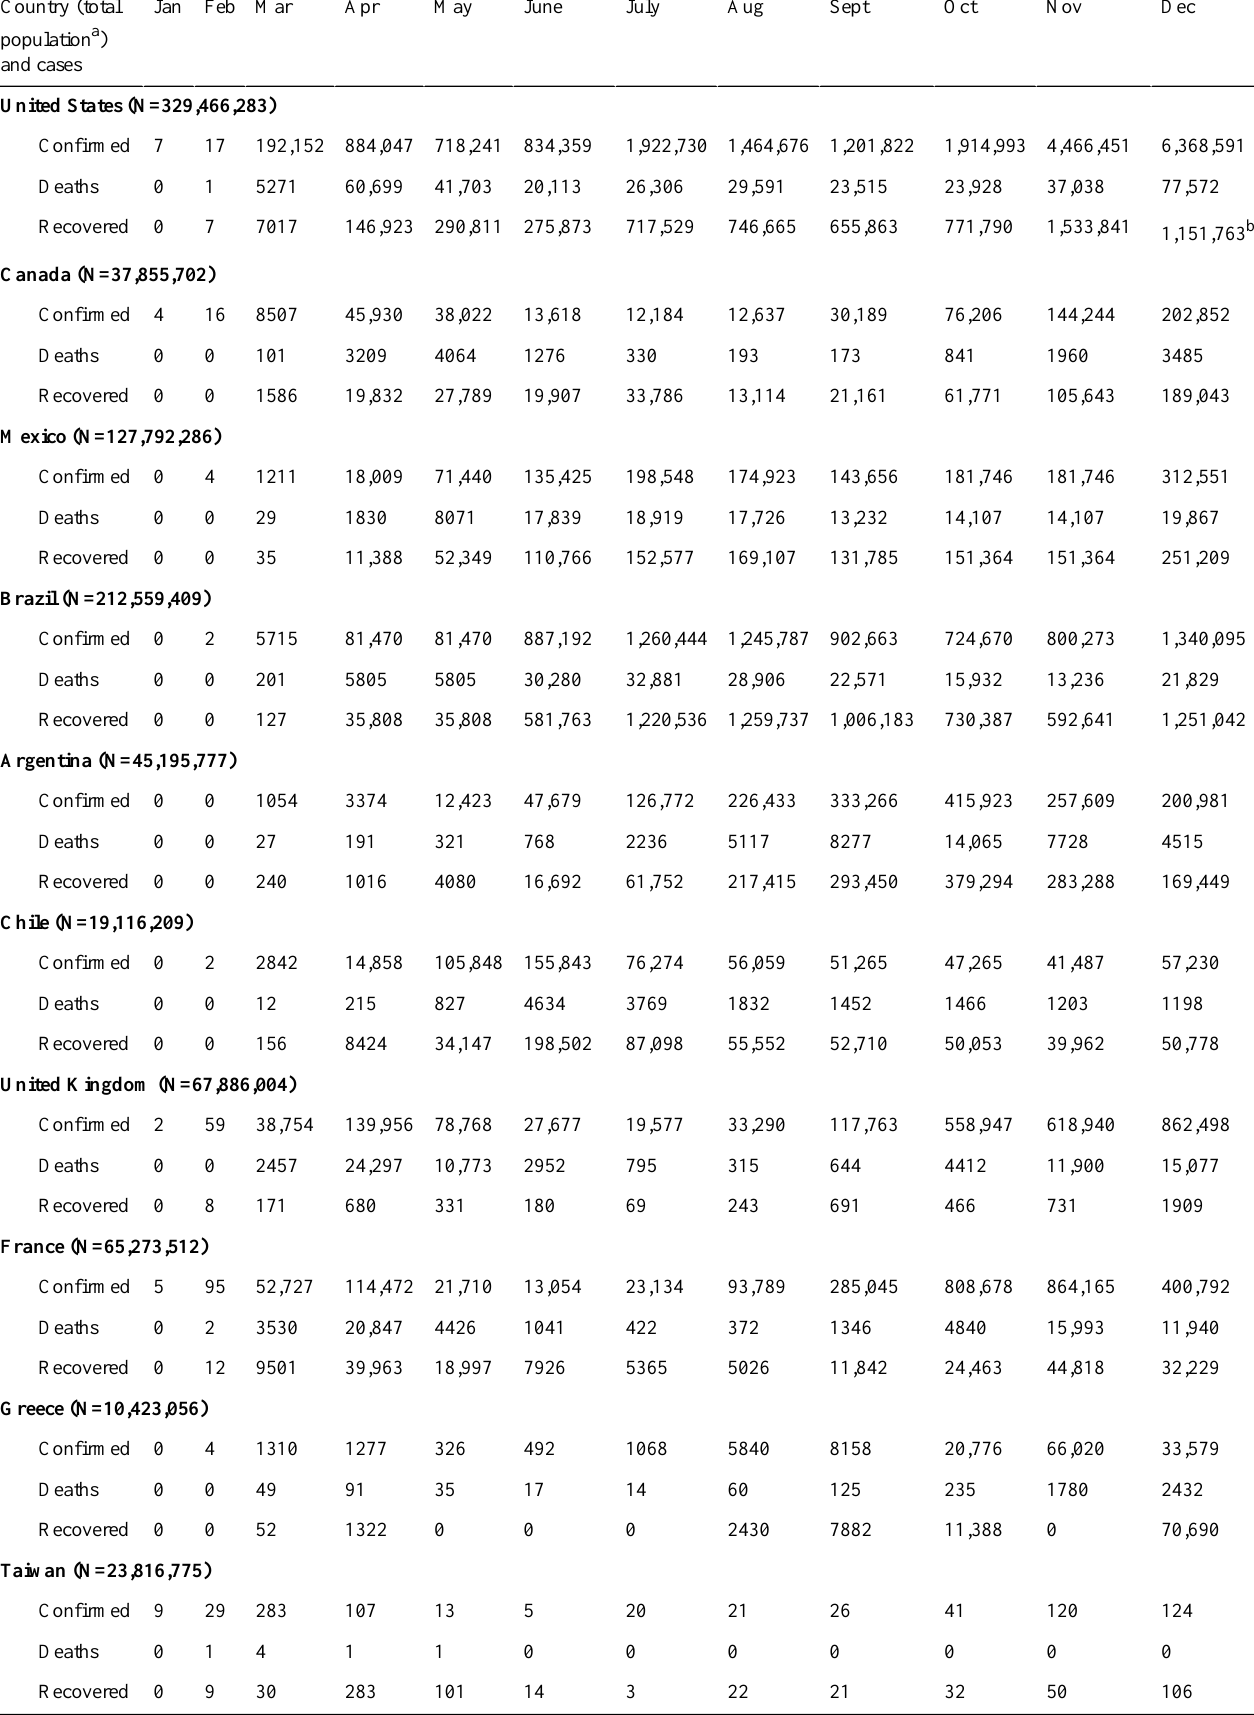
Table 1. The numbers of confirmed cases, recovered individuals, and deaths in 15 countries by month in 2020. DecNovOctSeptAugJulyJuneMayAprMarFebJanCountry